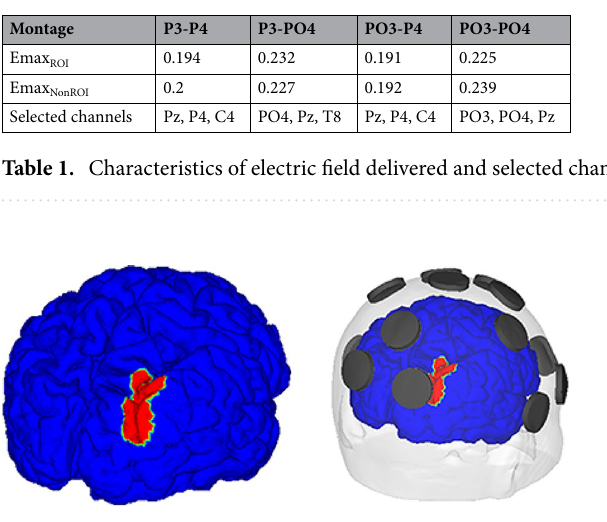
Figure 4. The ROI and an exemplary demonstration of electrode configuration relative to the ROI (PO3-PO4 montage, only for illustrational